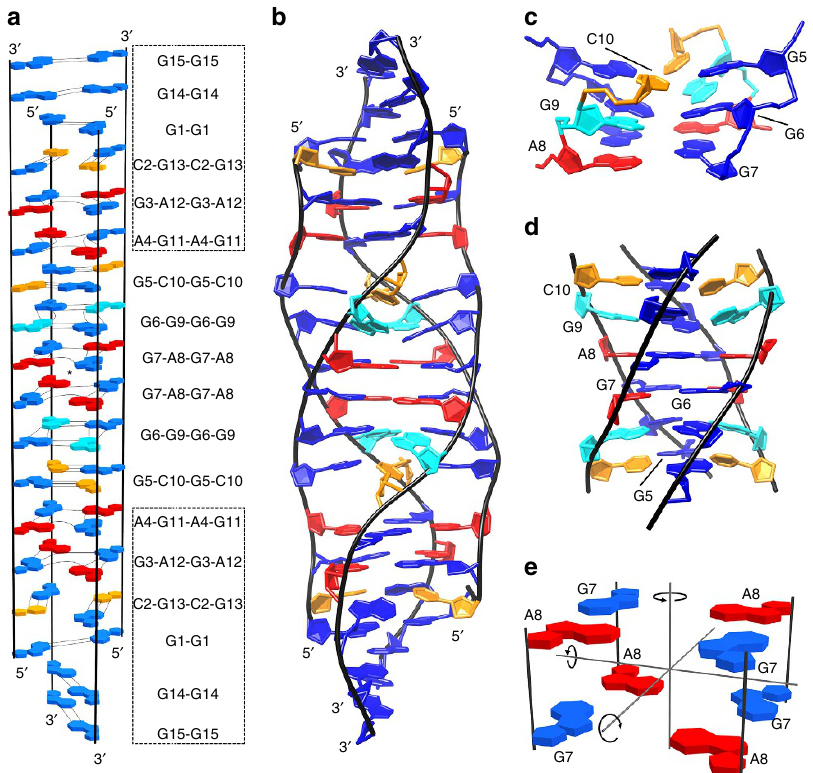
Figure 5 | Schematic representation and the lowest-energy structure of the VK34 tetramer. ( a ) Schematic representation of the VK34 tetramer. The asterisk marks the intersection point of three C 2 rotational axes of symmetry. ( b ) Cartoon representation of the overall lowest-energy structure (PDB ID: 5M2L). ( c ) G7-A8-G7-A8, G6-G9-G6-G9 and G5-C10-G5-C10 quartets. ( d ) View into a narrow groove of the central region. ( e ) Two stacked GAGA-quartets with C 2 rotational axes of symmetry. The guanine bases in anti orientation are coloured in blue, guanines in syn orientation in cyan, adenine in red and cytosine in orange. Hydrogen bonds are shown as dotted black lines. The dashed boxes in a highlight parts of the structure that adopt similar structural arrangements as in the dimeric